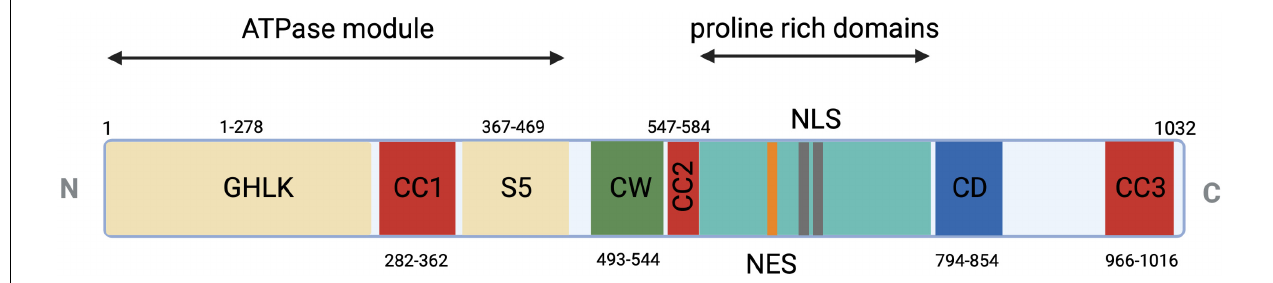
FIGURE 1 | Schematic representation of MORC2 domain architecture. Conserved ATPase module in beige (1–469 a.a.) is a split module composed of GHKL (1–278 a.a.) and S5 (367–469 a.a.) domains. CW-ZF or zinc finger domain is represented (490–544 a.a.) in green and multiple coiled coils in red as CC1 or coiled coil 1 (282–362 a.a.), CC2 or coiled coil 2 (547–584 a.a.), CC3 or coiled coil 3 (966–1016 a.a.). Two unique domains, proline-rich domain (581–788 a.a.) and CD or chromo-like domain (794–854 a.a.), are shown in cyan and blue, respectively. Additional nuclear export signal (691–703 a.a.) and nuclear localization signal (734–742 a.a. and 755–771 a.a.) are shown in orange and gray, respectively.